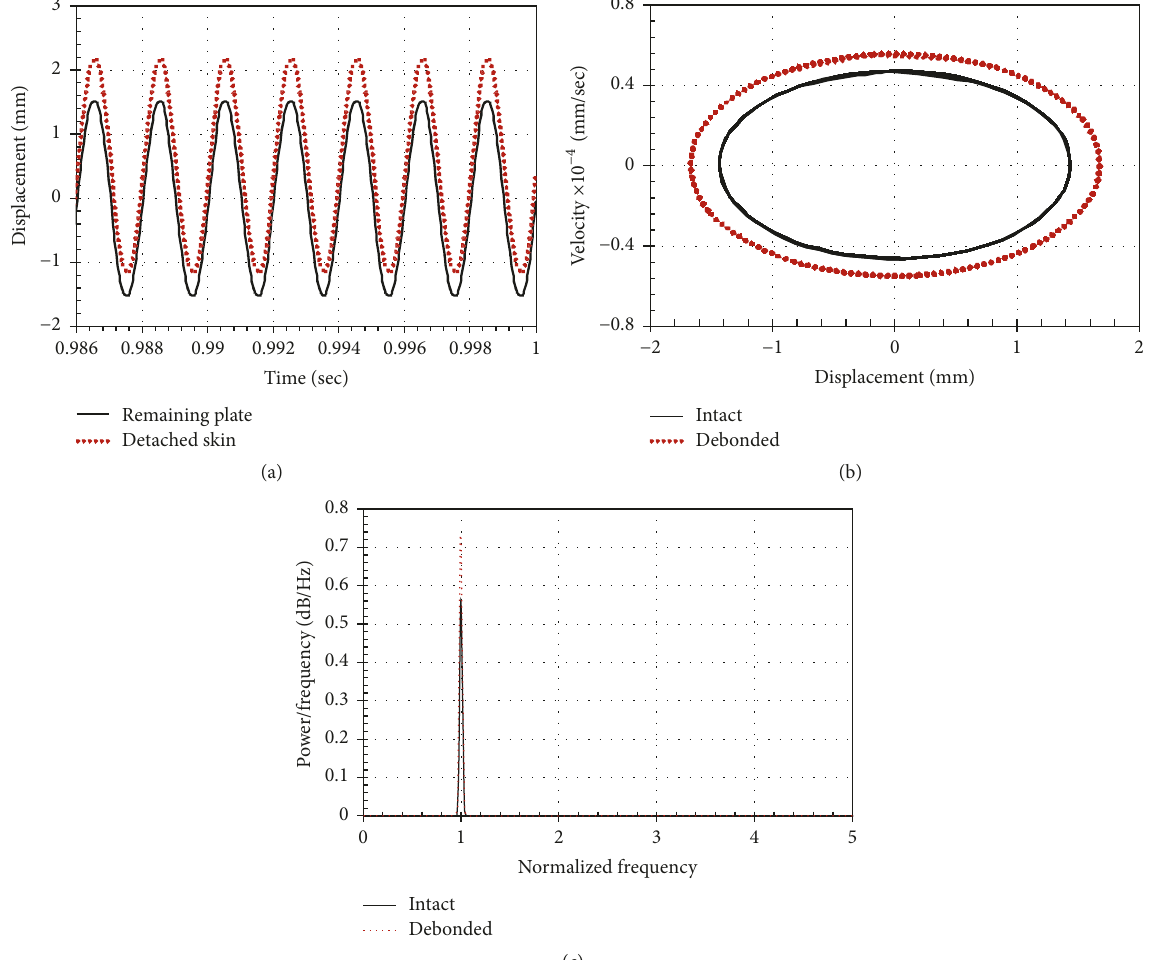
Figure 22: Steady-state dynamic response at 𝜂 = 1/2 (Ω = 500 Hz ) [80]: (a) displacement time histories at points N2 and N3; (b) phase portrait at point N1; and (c) frequency spectra of the displacement signals at point